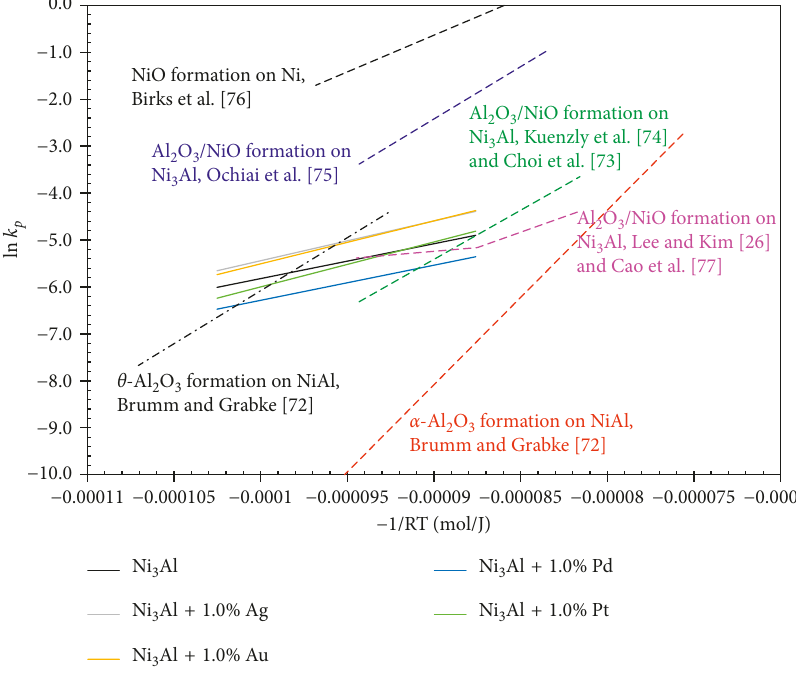
Figure 7: Arrhenius graph showing the k p variation in function of temperature. Table 5: Values of k 0 and Q obtained from the Arrhenius graph.